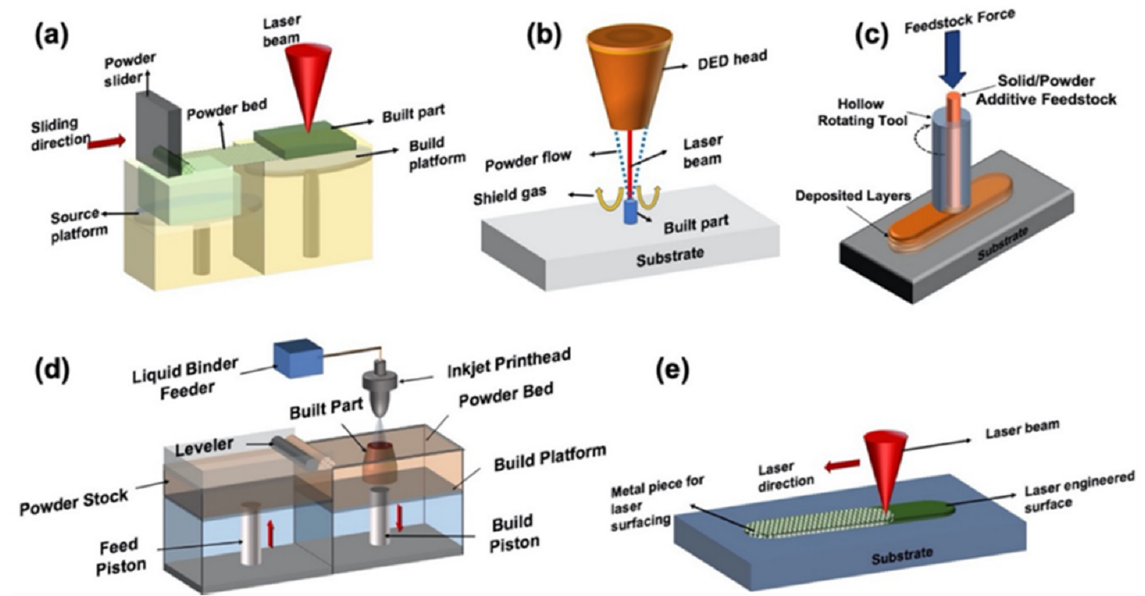
Figure 2. The schematic diagram for ( a ) LPBF, ( b ) DED fusion bed AM processing, ( c ) friction stir AM solid-state processing,